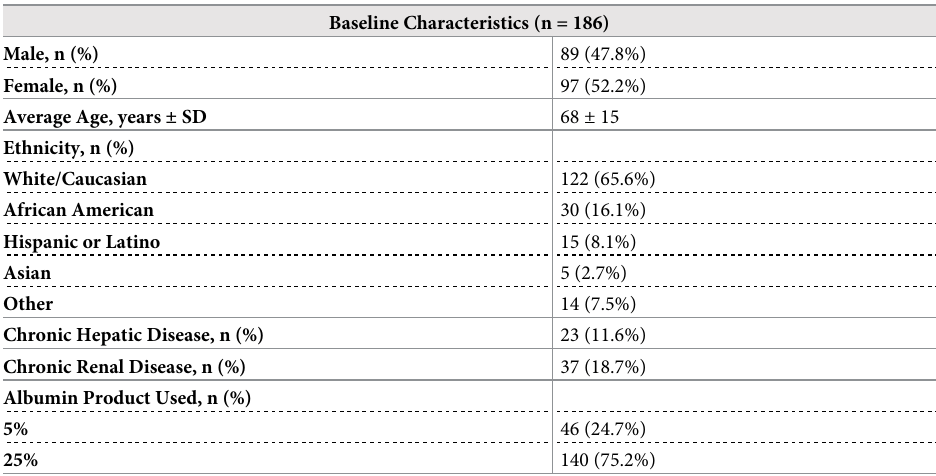
Table 1. Baseline